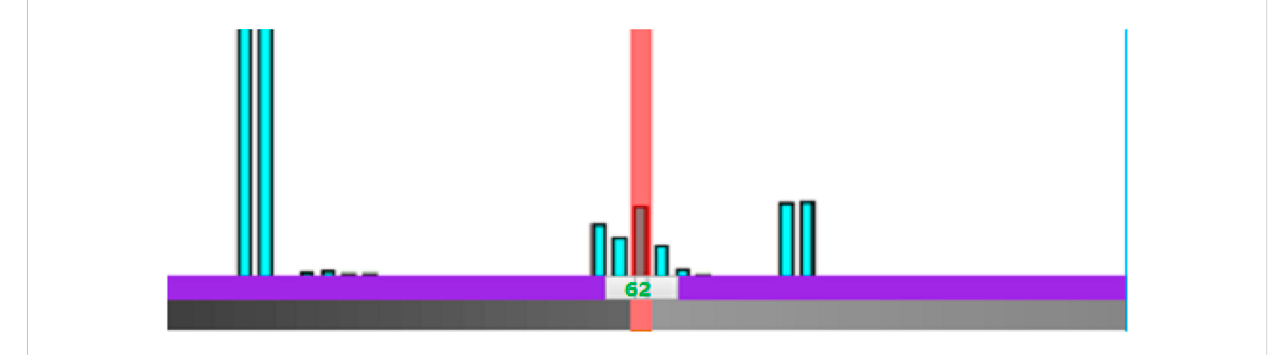
FIGURE 1 The interactive cardiac physical modality